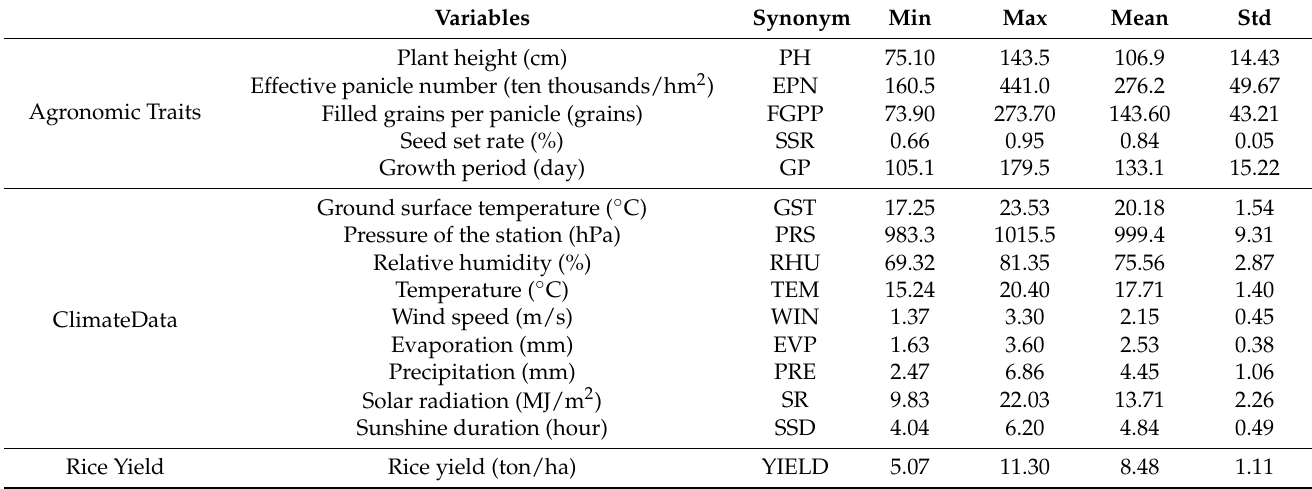
Figure 1. Location of the study area and climate stations in China. Table 1. Statistics of collected